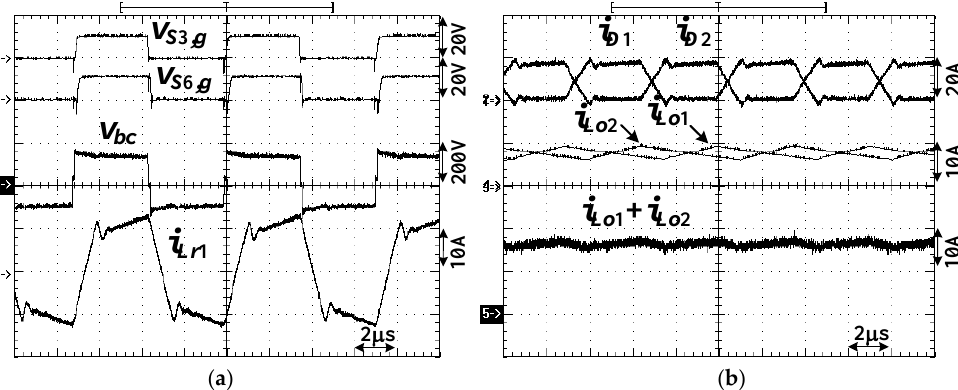
Figure 5. Laboratory prototype: ( a ) circuit diagram; ( b ) picture of prototype circuit.